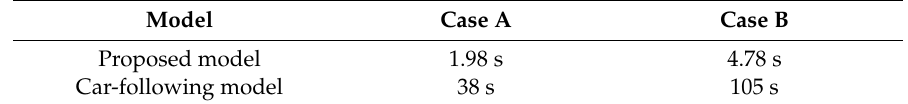
Table 6. Computation time comparison between the proposed model and the car-following